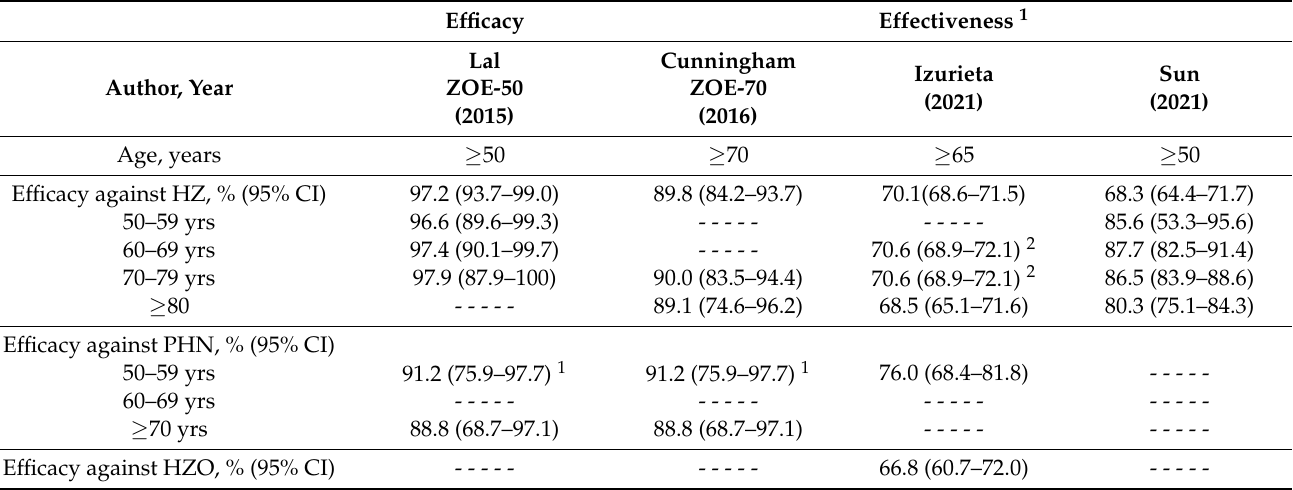
Table 2. Efficacy and effectiveness of the recombinant zoster vaccine (RZV) in